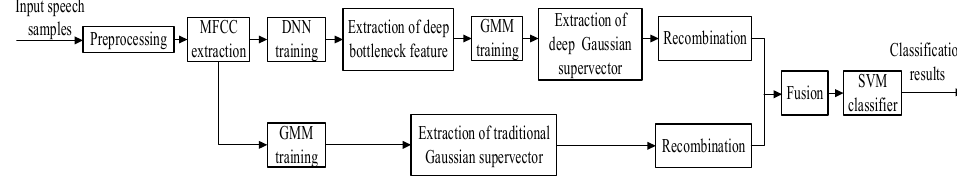
Figure 1. Proposed speaker recognition model based on the fusion of deep and shallow features.